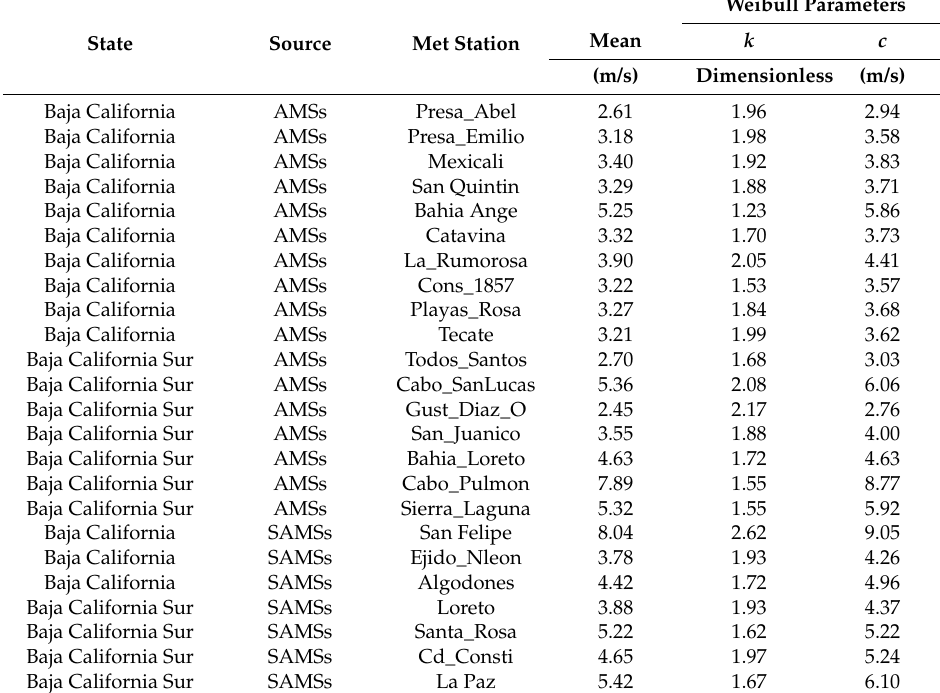
Table 3. Weibull Parameters of AMSs and SAMSs at the Baja California